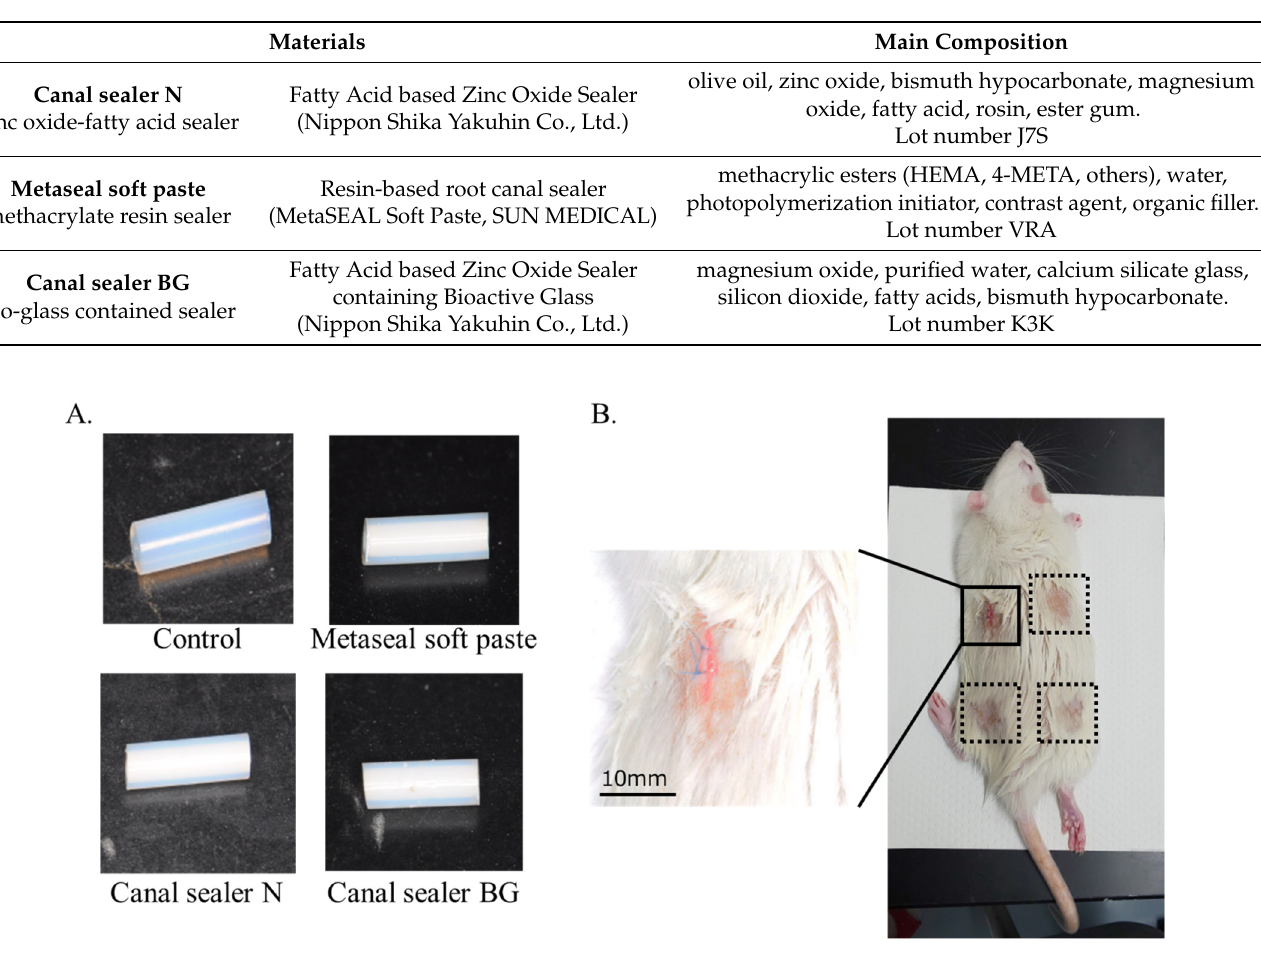
Figure 1. Subcutaneous implant model for root canal sealers. Three different kinds of materials were randomly implanted in four locations under the rat’s back skin. Representative image of each sample before implantation(A). Samples were randomly implanted into four locations subcutaneously (B). The magnified image shows sutures after implantation.